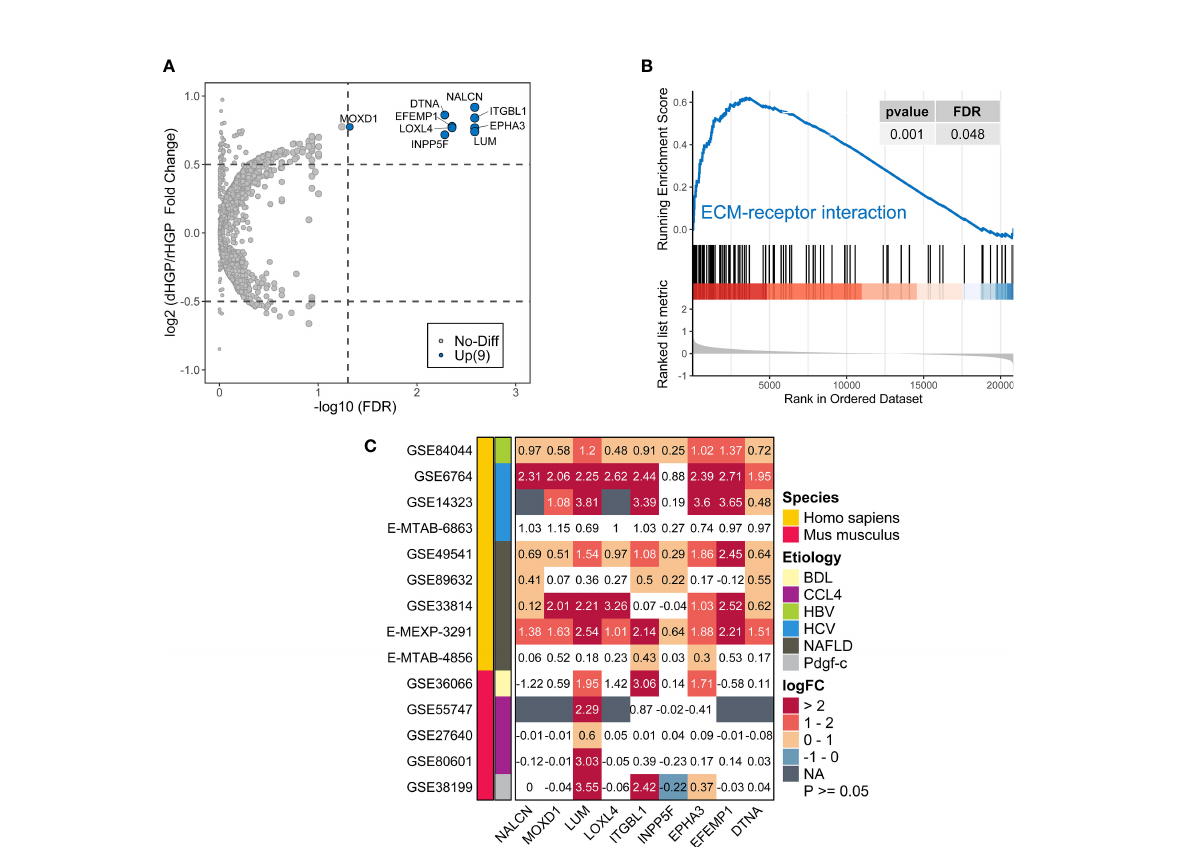
FIGURE 4 Comparison of the transcriptome landscapes of normal liver tissues between 20 dHGP and 15 rHGP patients. (A) Volcano plot showing 9 upregulated DEGs in the dHGP subgroup (|LogFC| > 0·5, FDR < 0·05). (B) Enrichment plots showing ECM receptor interaction pathways in the dHGP group. (C) Heatmap depicting the differential expression of 9 DEGs in the fi brosis or cirrhosis group versus the normal group in 14 public datasets of fi brotic livers caused by non-cancerous diseases. Numbers in each square box represent the fold change. NAFLD indicates nonalcoholic fatty liver disease. HCV indicates the hepatitis C virus. HBV indicates the hepatitis B virus. BDL indicates bile duct ligation. CCL4 indicates carbon tetrachloride. Pdgf indicates platelet-derived growth factor (C) BDL, CCL4, and Pdgf-c are the modeling methods of liver fi brosis in